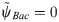
Sensitivity analysis for antibiotic concentration and inhibitor dose—4 weeks.The log10 of the total number of bacteria at 4 weeks (672 hr), BT(672), is plotted for a range of antibiotic concentrations and inhibitor doses. Note that inhibitor treatments are plotted as multiples of the standard dose (6.12×107 inhib. cm−3) and that values of BT(672) < 1 are plotted as BT(672) = 1 to maximise visual clarity. The white curves are the contours along which BT(672) = 1; hence, BT(672) < 1 above-right of these contours. The effect of treatment is relatively minor in Cases A and D; however, the bacterial burden may be eliminated for sufficiently high antibiotic concentrations and inhibitor doses in Cases B and C. Eqs 1–11 were solved using ode15s and with a constant antibiotic concentration. Parameter values: ψ˜Bac=0 hr−1, ψ˜I=0 hr−1, λ = 0 cm3cell−1hr−1, ρ = 0 hr−1 and ω = 1. See Tables 2–4 for the remaining parameter values.